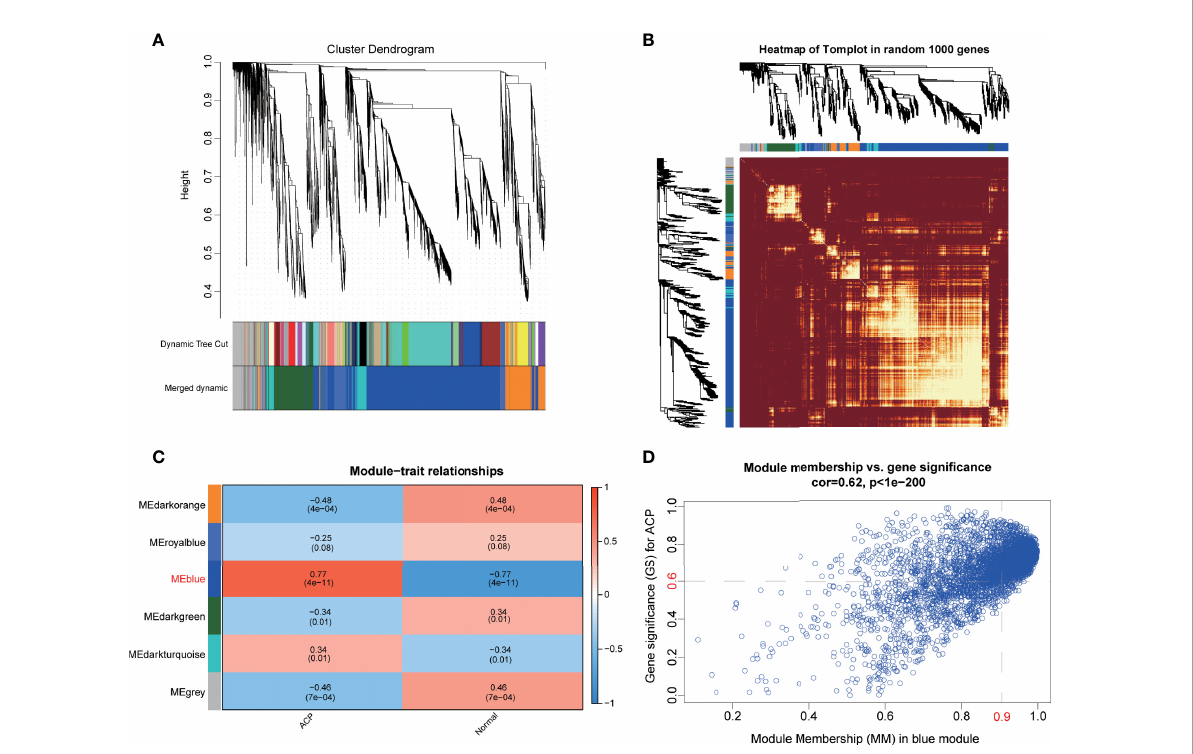
FIGURE 2 Screening pivotal modules and hub genes closely associated with ACPs by weighted gene coexpression network analysis (WGCNA). (A) . The dendrogram of all genes showing that a total of six modules were eventually identi fi ed after merging similar modules. (B) . The heatmap displayed the interrelation and stability of these modules based on the expression of random 1,000 genes. (C) . The blue module showed the highest correlation with ACP patients, with the coef fi cient = 0.77 and P= 4e-11. (D) . Scatter plot of the blue module identi fi ed 1,858 hub genes to manifest the module ’ s characteristics based on the screening criterion with high module membership (MM) and gene signi fi cance (GS)